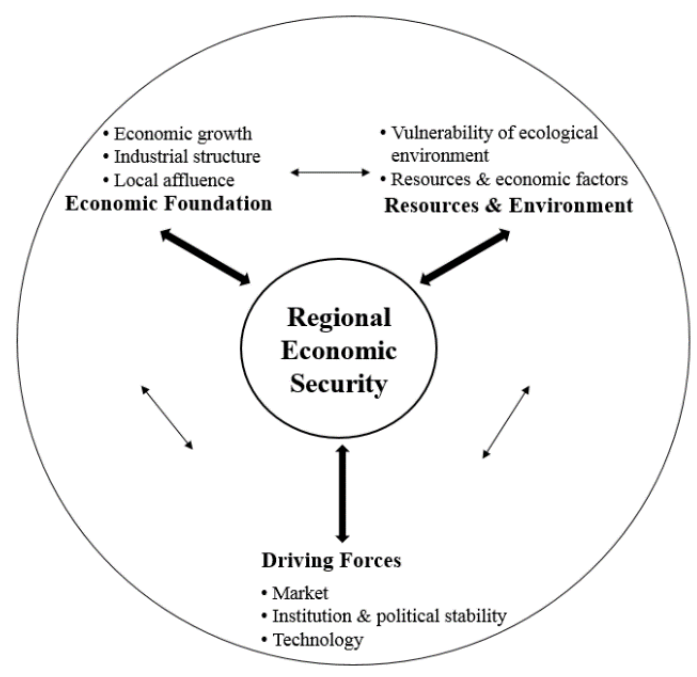
Figure 3. Analytical framework of RES assessment.